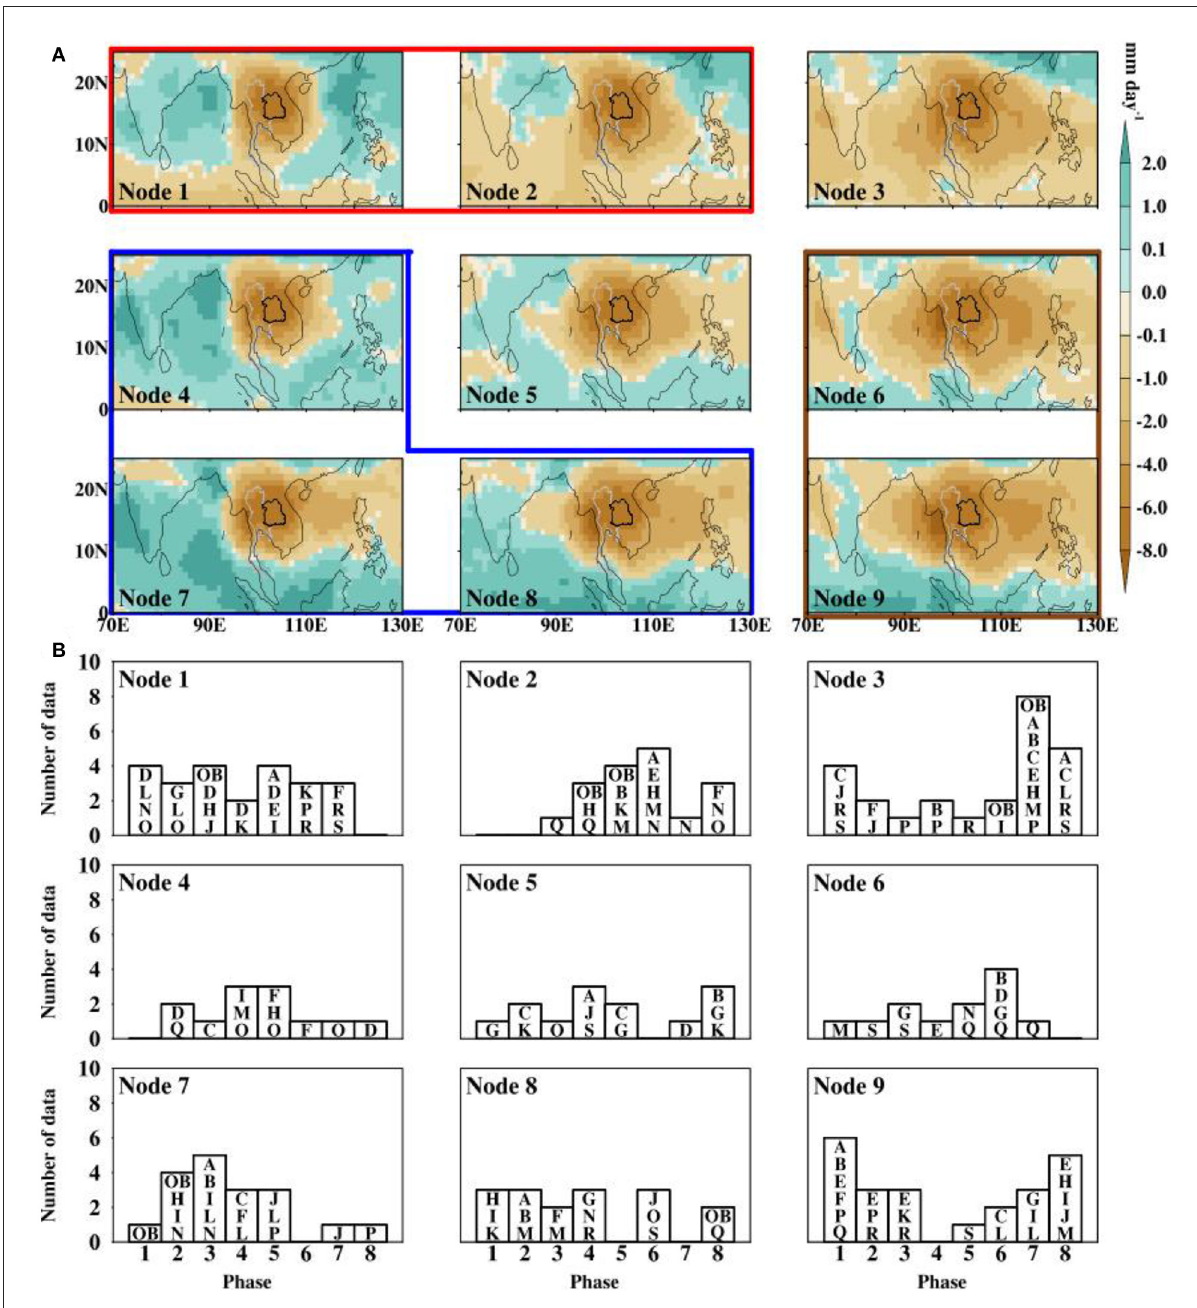
FIGURE11 (A) The 3 × 3 SOMs distribution of evolution of rainfall anomalies over NE Thailand during the active BSISO phase [top panels; (A) ], and the frequency distribution of data for each phase in the SOMs nodes [bottom panels; (B) ]. The alphabet tag in each bar represents the code of the models that make up the bar (Table